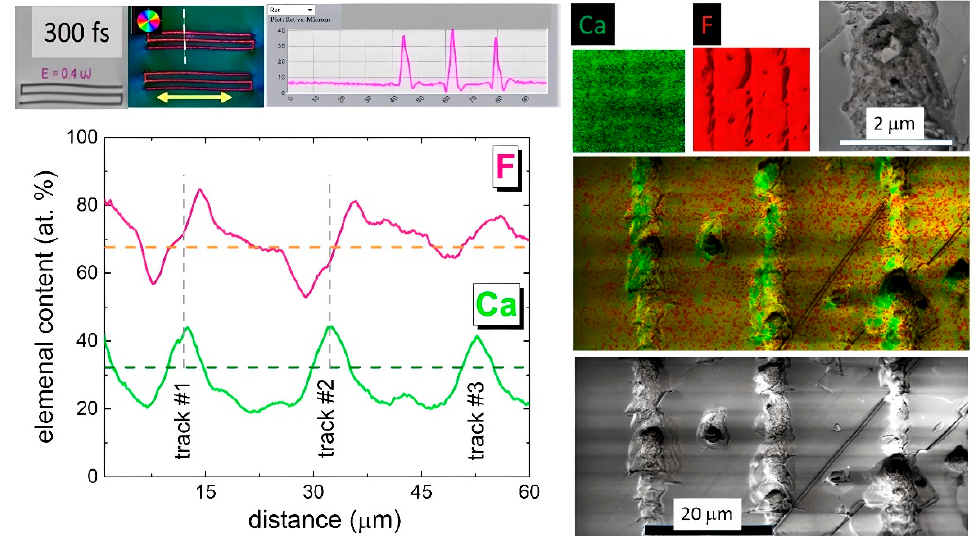
Figure 5. (Top line, left to right) Optical and polarimetric images of three-line buried microstructures inscribed by 0.3 ps, 515 nm laser pulses, and the corresponding retardance profile. Their cross- sectional EDX surface elemental color maps (Ca,F) and a magnified SEM image of one microstructure fragment. (Bottom line, right to left) Cross ‐ sectional magnified and combined EDX elemental map of Ca (green color) and F (red color) across the three ‐ line structure and its SEM image. Profiles of Ca and F across the three ‐ line structure.